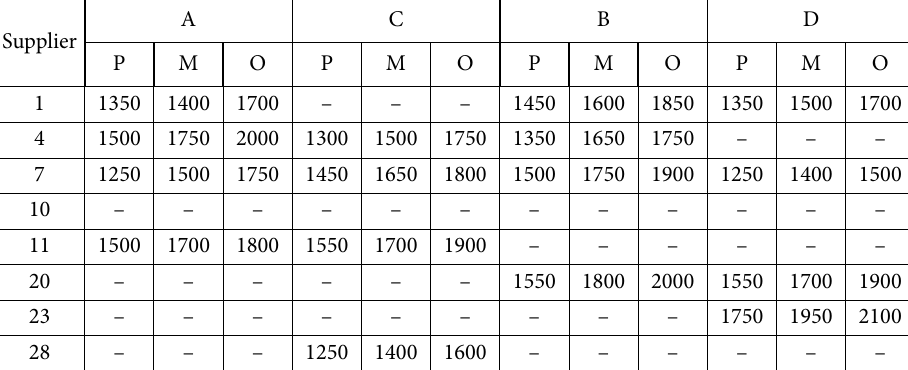
Table 30. Triangular fuzzy capacity of suppliers for components